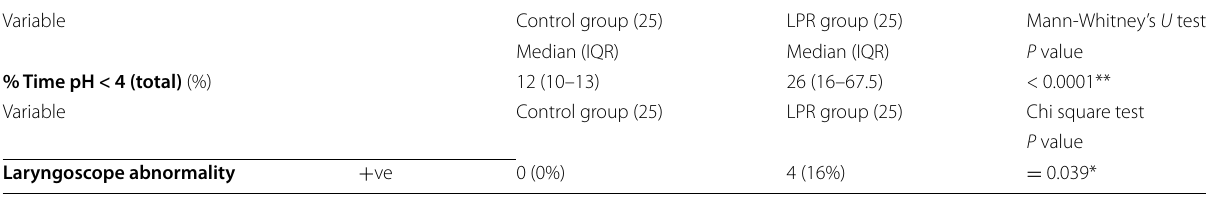
Table 2 Comparison between the 2 groups as regards laryngoscopic and pH-metry data using Mann-Whitney’s U and chi-square